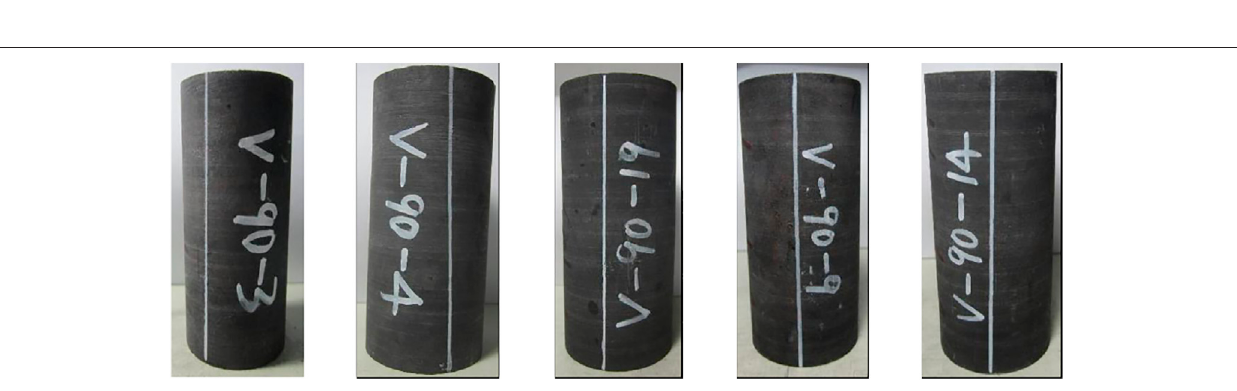
FIGURE 3 | Representative samples of the study (diameter = 5 cm, length = 10